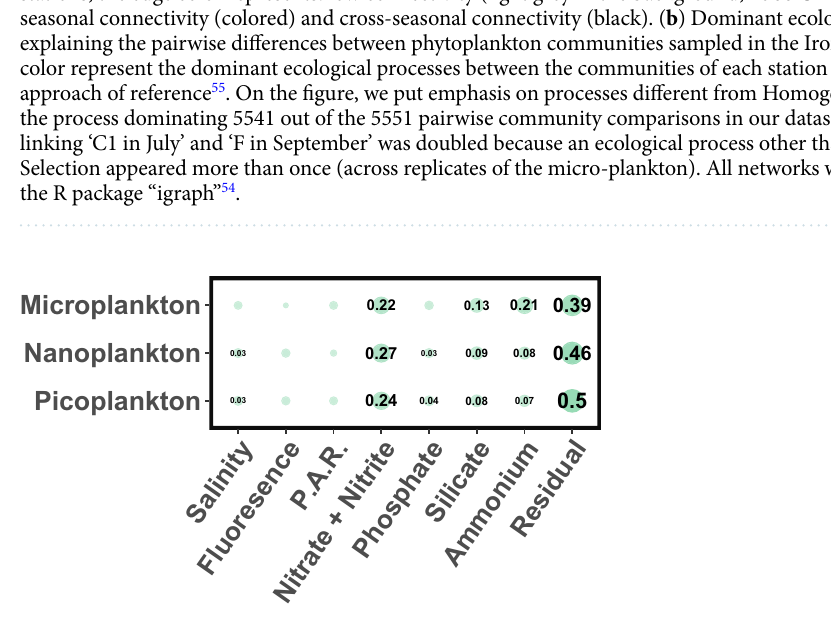
Figure 5. Permutational multivariate analysis of variance (PERMANOVA) between the phylogenetic community turnovers of eukaryotic phytoplankton (ß-Mean Nearest Taxon Distance) and hydrographic variables measured in the Iroise Sea. The value of the R 2 of the PERMANOVA is displayed when the p value between the two variables was < 0.05. The analysis was repeated for each